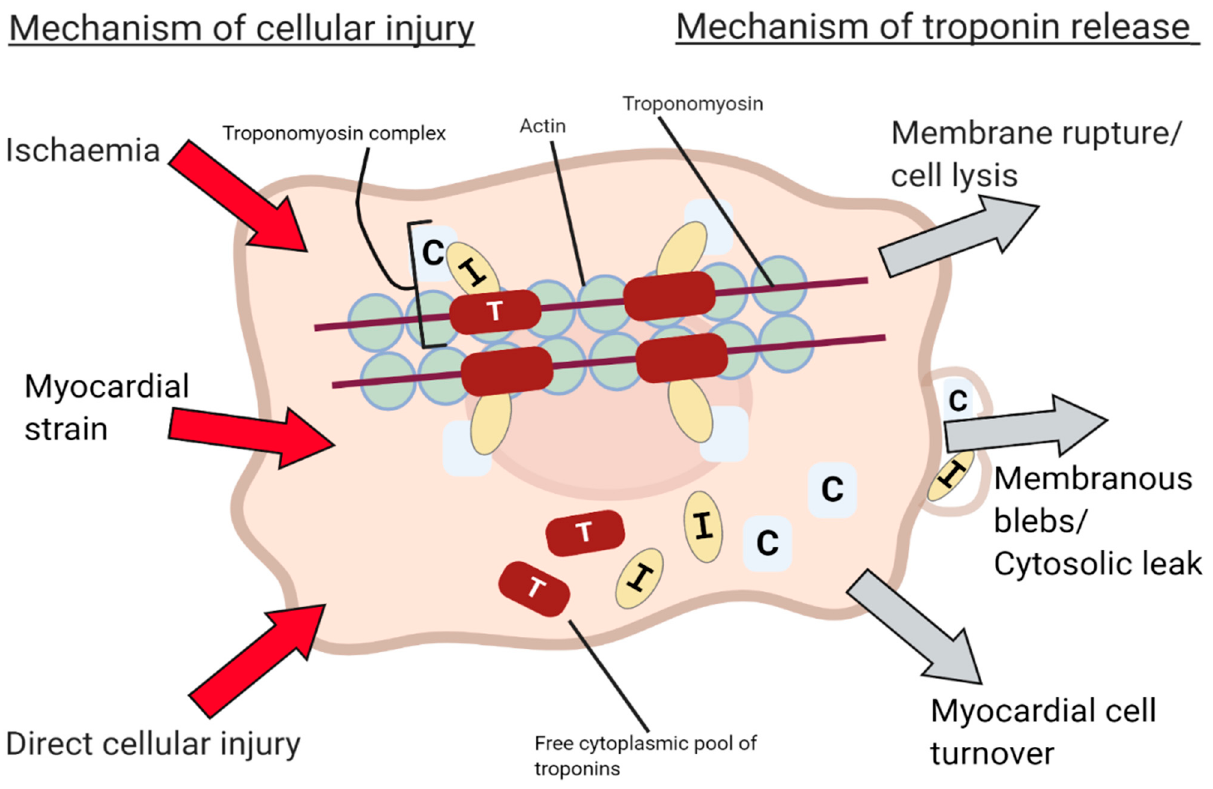
Figure 2. Proposed mechanisms of cardiac cell damage and troponin release.